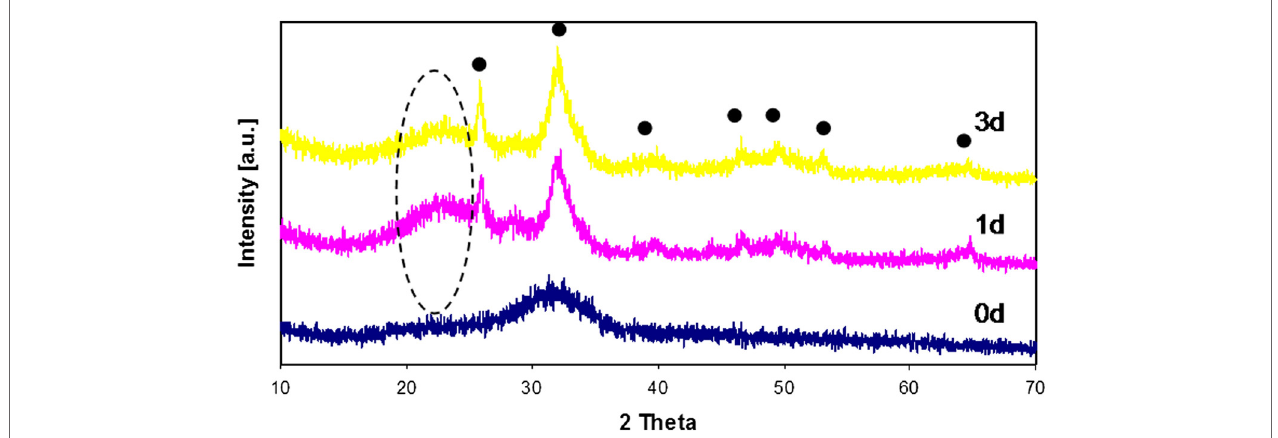
FigUre 2 | XrD patterns of 45s5 (Bg) before and after sBF treatment up to 3 days . (•) Hydroxyapatite, (–) silica gel.